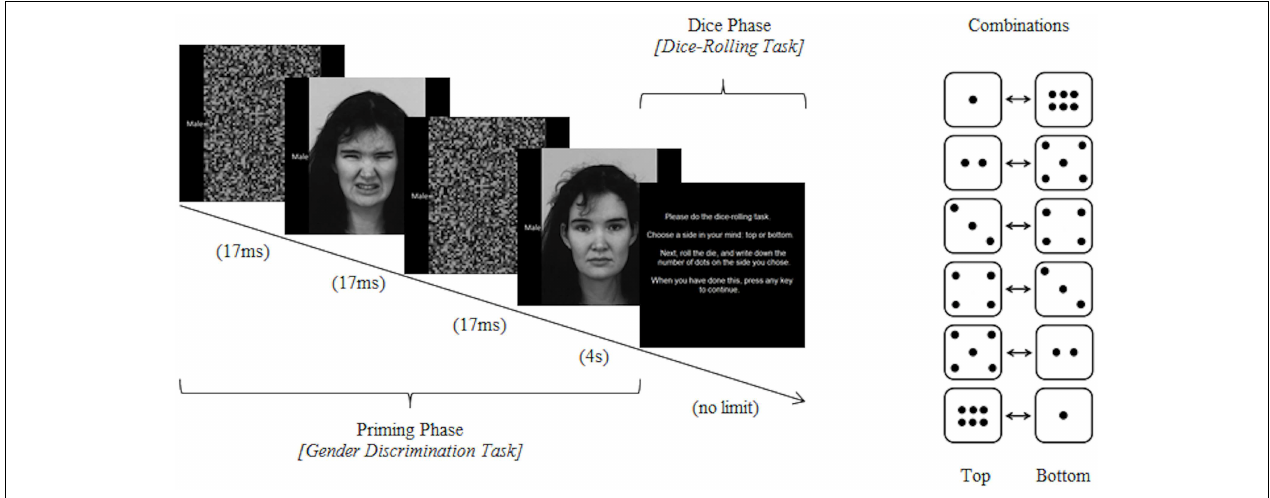
FIGURE 1 | Schematic of one trial of the task paradigm. Subjects first performed the gender discrimination task, during which they were primed subliminally with a facial image with either a disgust or neutral expression.